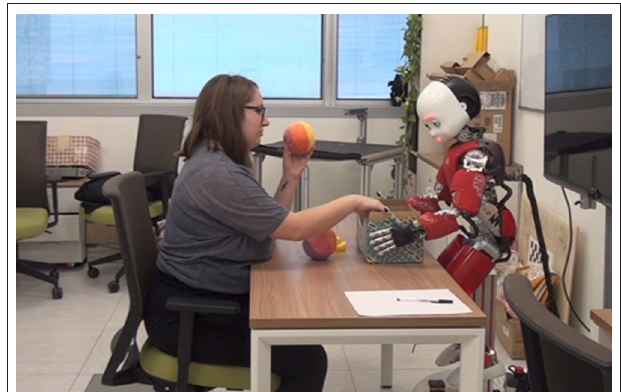
FIGURE 2 | The layout of the laboratory setup. Informed consent of participants has been obtained for the use of their